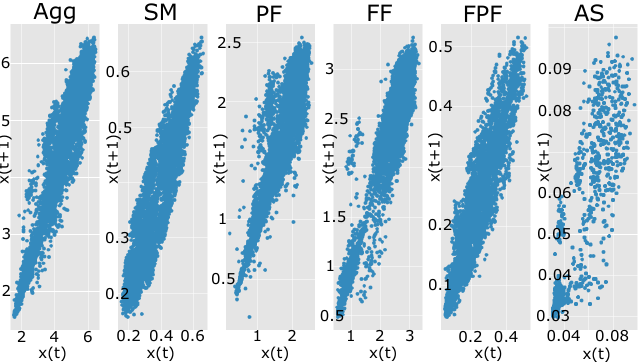
Figure 3. Lag 1 applied for each time series for distribution